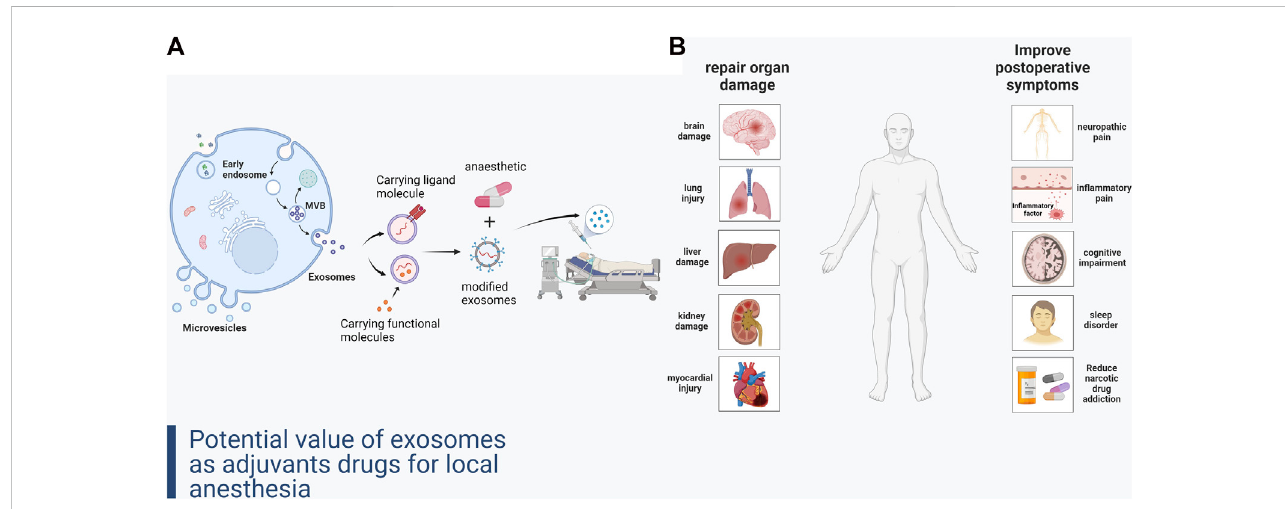
FIGURE 1 (A) Formation of exosomes and construction of local anesthetic adjuvant-like exosomal drugs. (B) Improvement of organ damage and complications after local anesthesia by